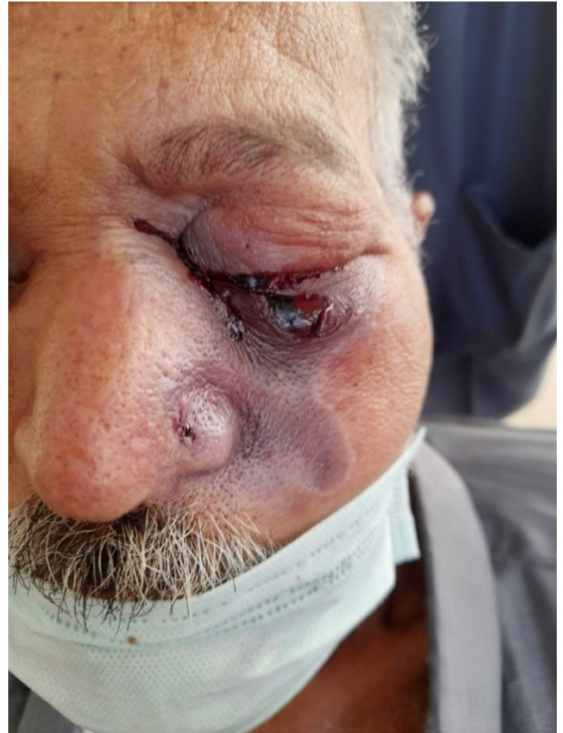
Figure 3. Extra-oral image of Case No. 3 revealed erythema, black discolouration, and an ulcer on the lower eyelid of the left